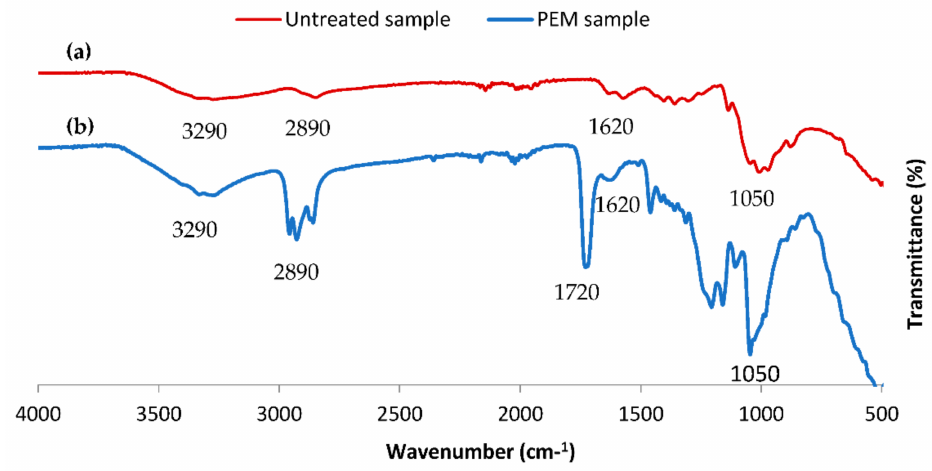
Figure 3. FT-IR spectra of untreated cellulosic sample and PEM functionalized bio-sorbent